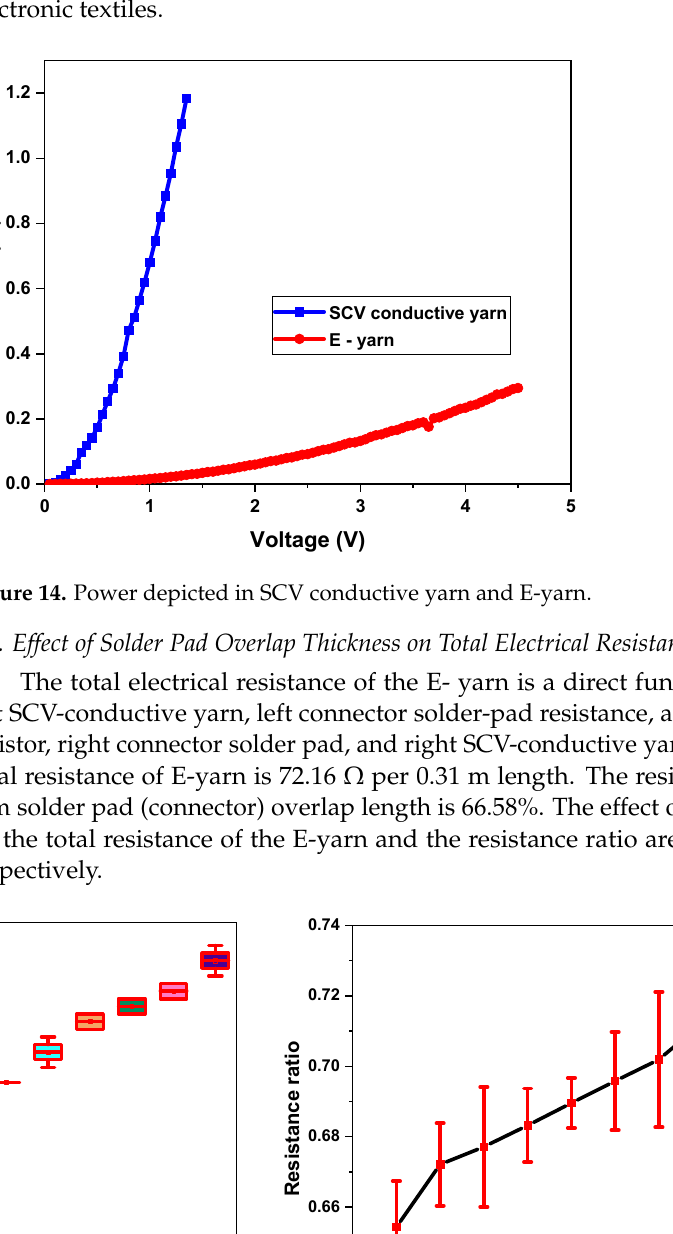
Figure 15. Effects of solder pad connector overlap thickness on total resistance of E-yarn ( A ) and its resistance ratio ( B ).